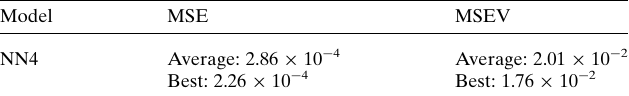
Table 3 The model’s performance in predicting EPU beam characteristics. The metrics in this table are computed on the scaled predicted values which lie in the range ( (cid:2) 1 to 1). The metrics of the best performing model from the compilation are included to illustrate the model’s performance potential.